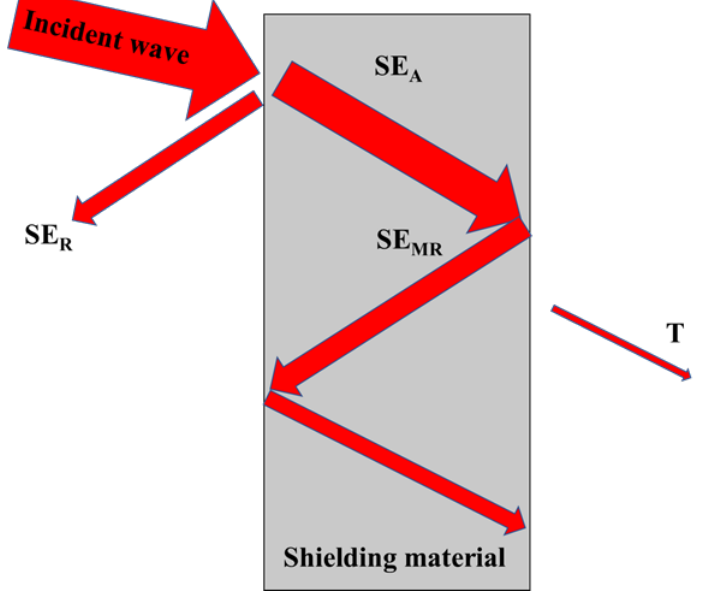
Figure 1. Transformation of the electromagnetic radiation (EMR) at the shielding material.